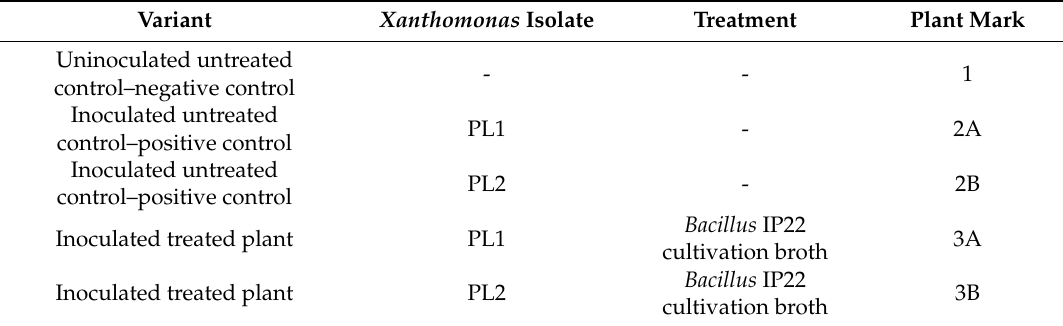
Table 1. Experimental plan in the phase of in planta antimicrobial activity